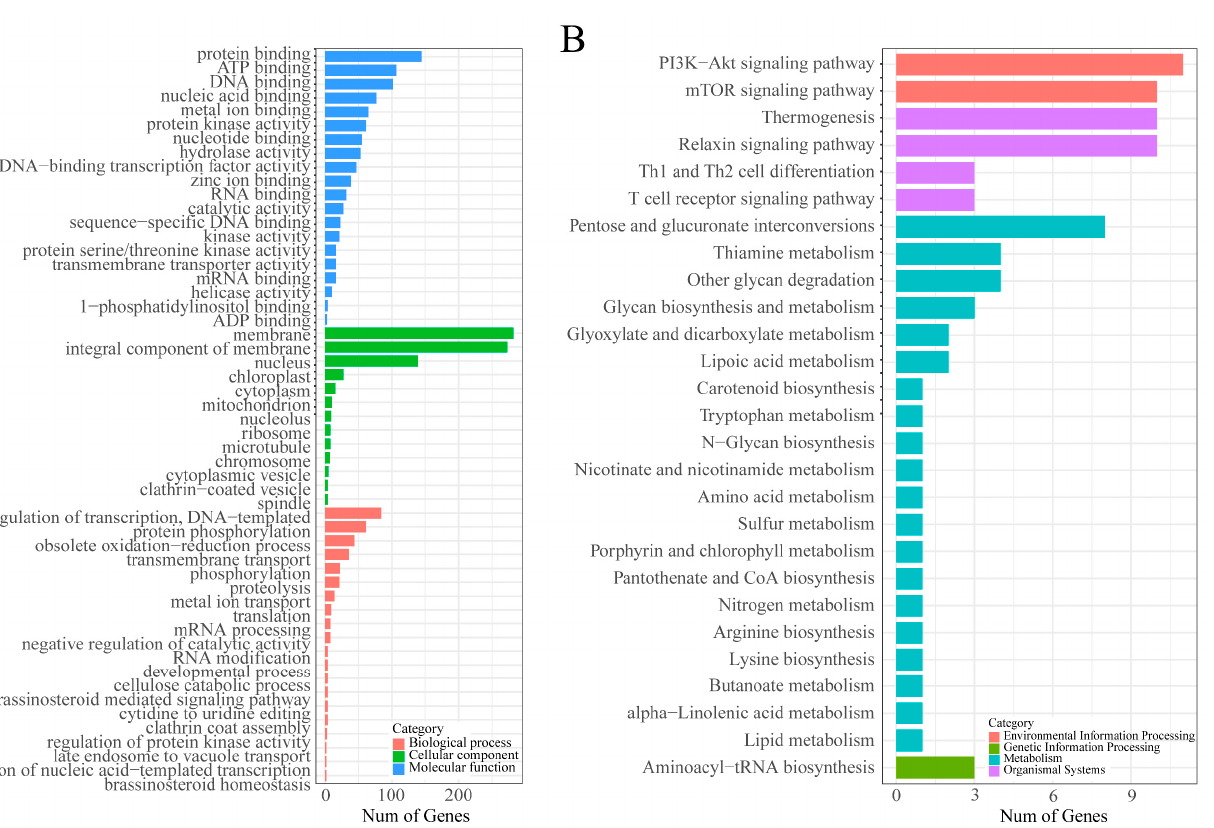
Figure 4. GO and KEGG enrichment analysis. GO classifications of CDSs with SSRs ( A ). KEGG pathway classifications of CDSs with SSRs ( B ).